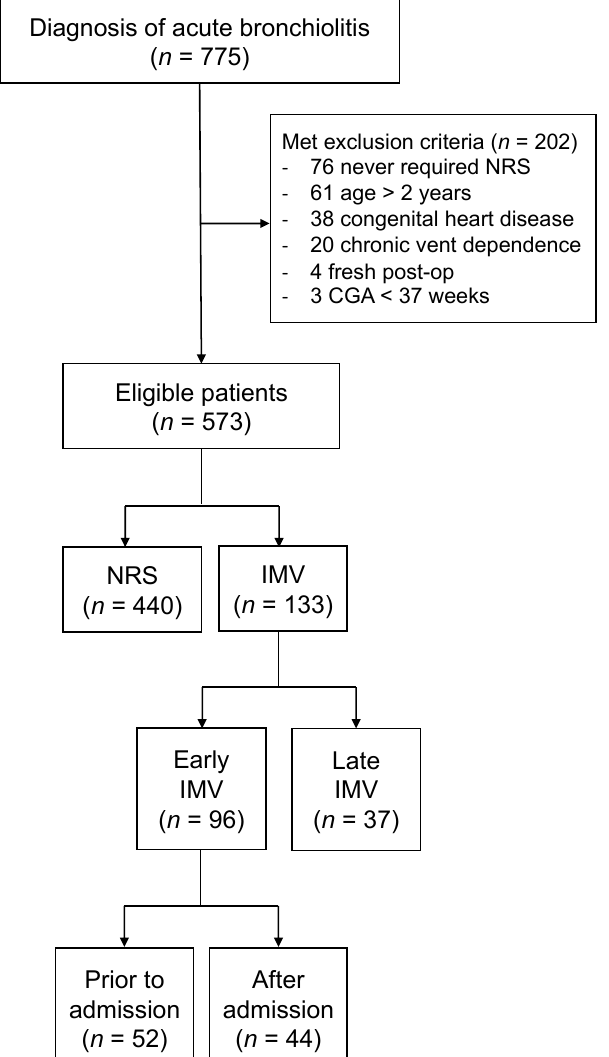
Figure 1. Patient enrollment flow diagram. CGA = corrected gestational age, IMV = invasive mechanical ventilation, NRS = non-invasive respiratory support, post-op = post-operation, vent = ventilator.